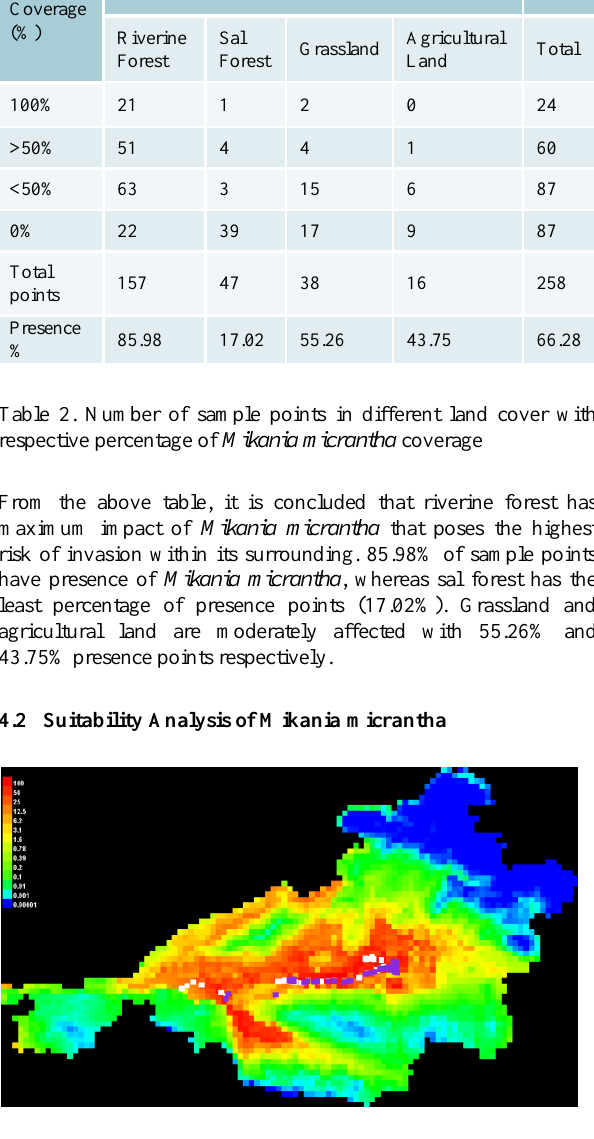
Figure 5. Potential invasion image generated using Maxent model The output image uses colors to indicate predicted probability that conditions are suitable, with red indicating a high probability of suitable conditions for the species, green indicating conditions typical of those where the species is found and lighter shades of blue indicating low predicted probability of suitable conditions. White dots show the presence locations used for training, while violet dots show test locations.